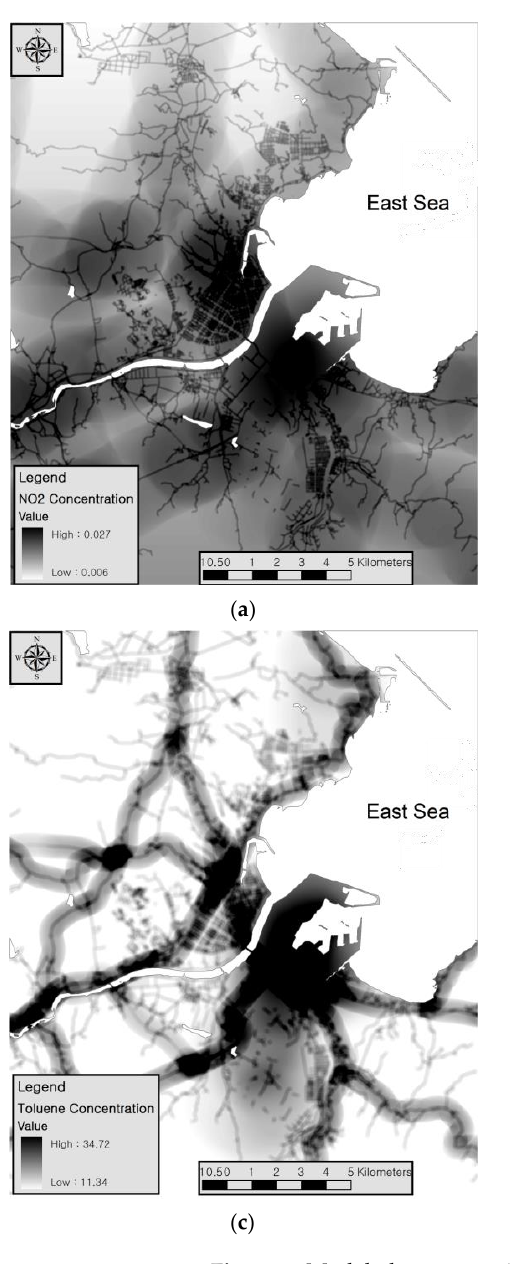
Figure 2. Modeled concentrations (µg/m 3 ) of NO 2 ( a ), benzene ( b ), toluene ( c ), and m-p-xylene ( d ) in Pohang.